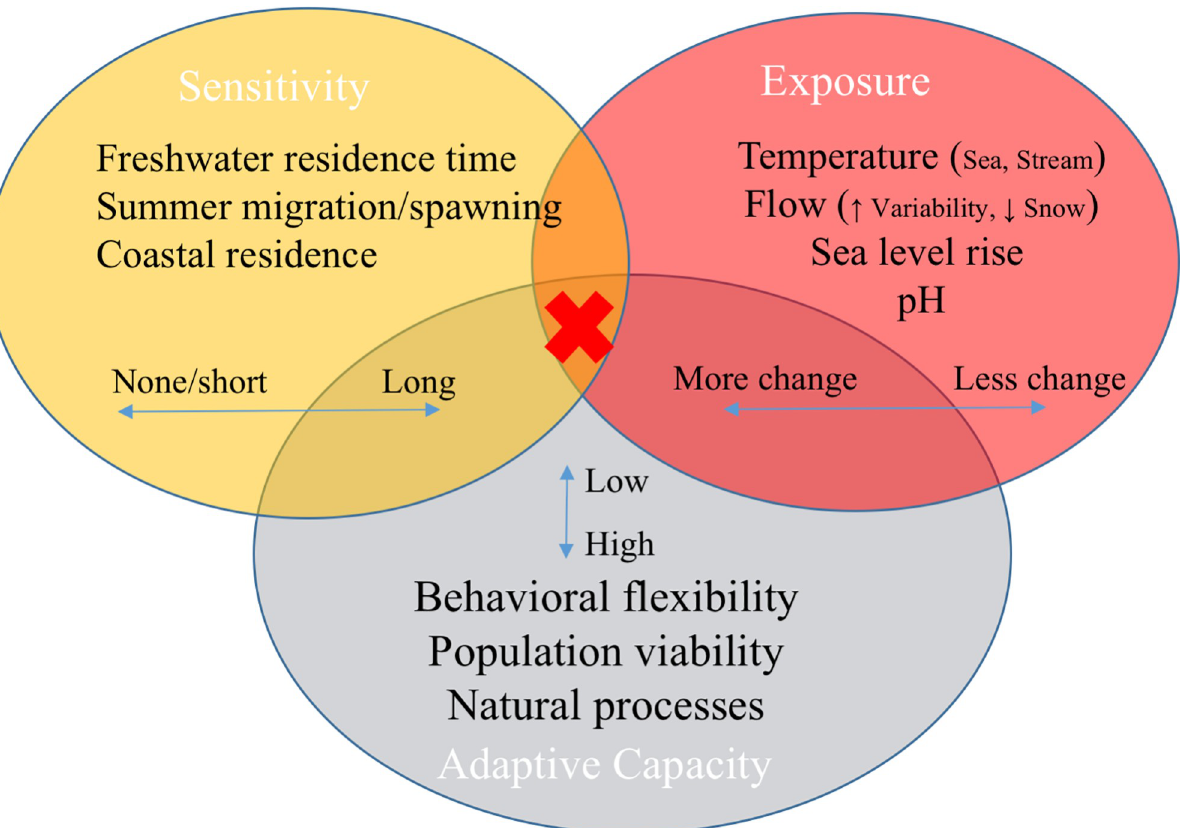
Fig 8. Conceptual model of highly influential attributes in final vulnerability ranks. The most vulnerable DPSs had scores in the intersection of high rates of change in exposure, long periods of sensitivity, and low adaptive capacity attributes (red x), as detailed in Table 4. Natural processes here refer to the absence of other stressors and hatchery